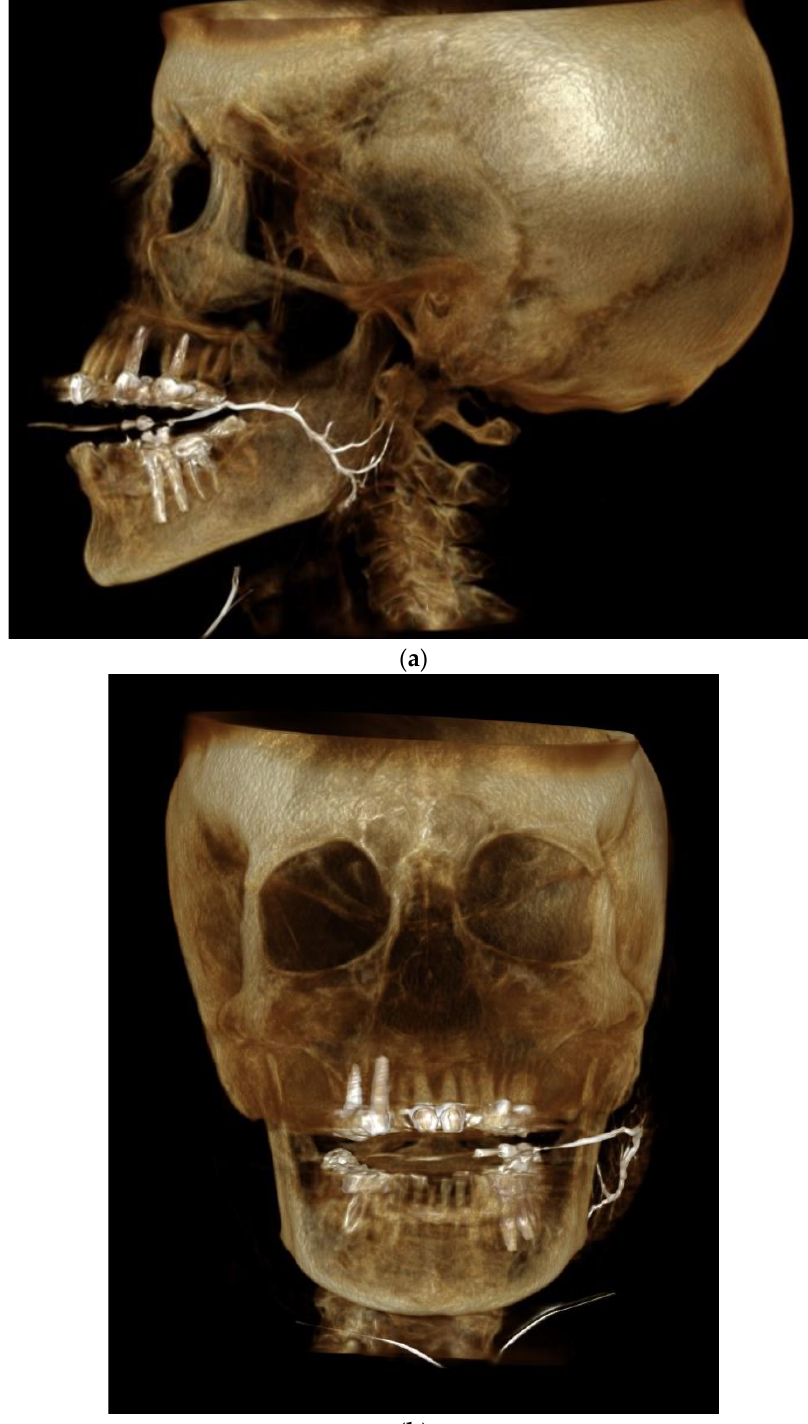
Figure 2. ( a ). Healthy parotid duct on cone beam CT sialography — lateral view. ( b ). Healthy parotid duct on cone beam CT sialography — anterior view.